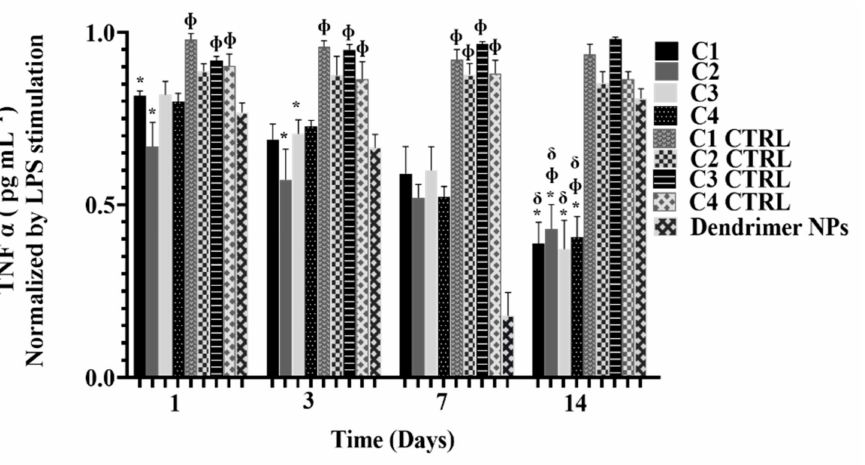
Figure 5. Quantification of TNF α free in the culture medium along 14 days of culture. Results were normalized by the TNF α values obtained in cultures stimulated by LPS. Data shown as Mean ± SD. * indicates significant differences when comparing with respective CTRL. Φ indicates significant dif- ferences when comparing with Dendrimer NPs at each time-point. δ indicates significant differences when comparing with day